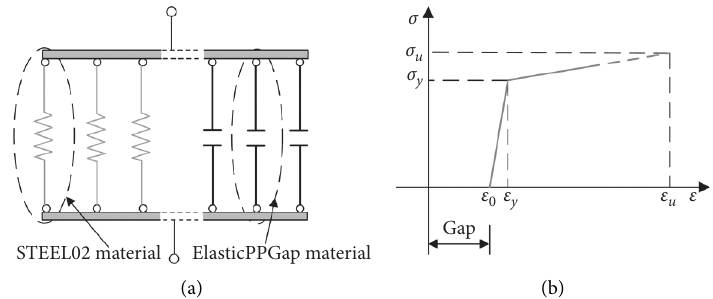
Figure 7: Parallel materials used to simulate the bolt bearing (adapted from [25]). (a) Structure of parallel materials. (b) Stress-strain relationships of a typical ElasticPPGap material to simulate stiffness increase due to bolt bearing.